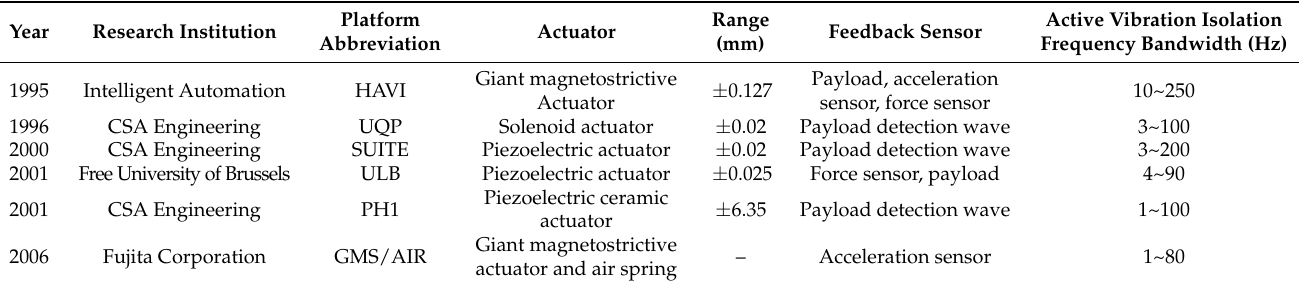
Table 2. Typical rigid Stewart platform.